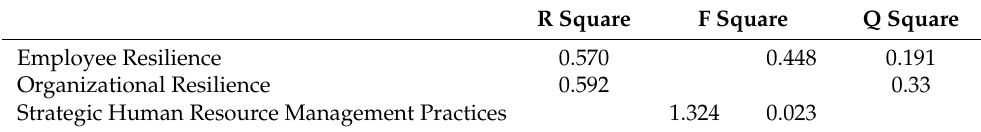
Table 5. Results of R 2 , f 2 , and Q 2